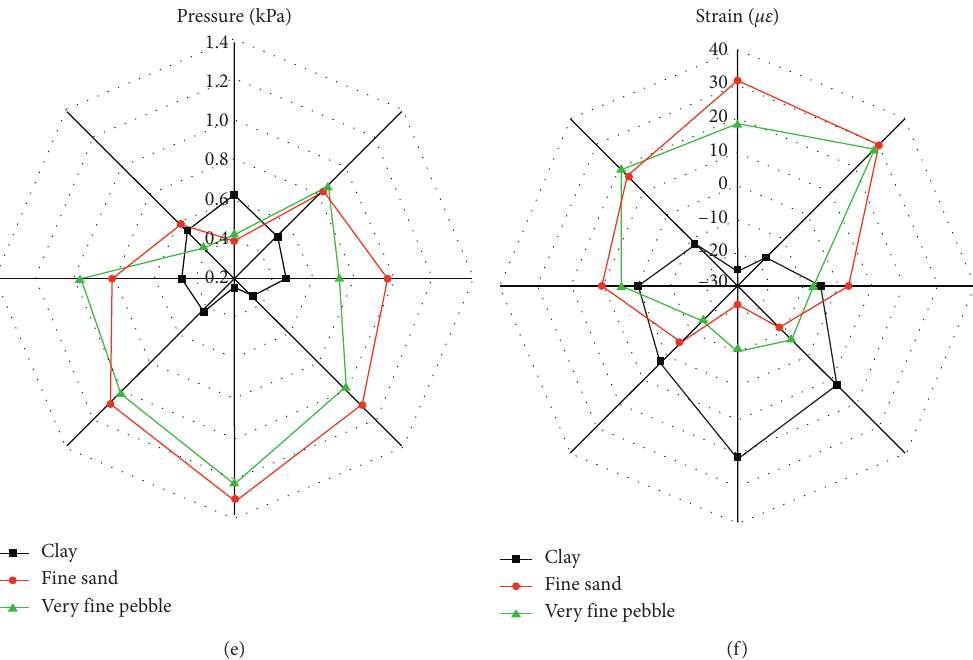
Figure 10: Pressure and strain on the surface of the pipeline which is buried under the riverbed: (a) pressure on the surface of the pipeline when the embedment ratio is − 2, (b) strain on the surface of the pipeline when the embedment ratio is − 2, (c) pressure on the surface of the pipeline when the embedment ratio is − 1.5, (d) strain on the surface of the pipeline when the embedment ratio is − 1.5, (e) pressure on the surface of the pipeline when the embedment ratio is − 1, and (f) srain on the surface of the pipeline when the embedment ratio is − 1.